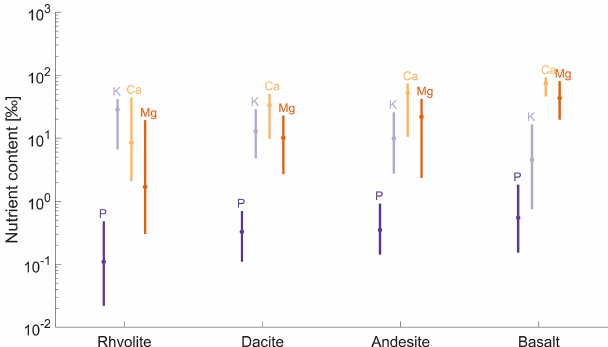
Figure 4. Statistical data of major element concentration in rocks with median values (filled circles) and range (5th and 95th per- centiles; whiskers). Values from EarthChem web portal (http:// www.earthchem.org, last access: 14 July 2017). The numbers of chemical analyses used to calculate the descriptive statistics were 2985 chemical analyses for rhyolite, 3008 chemical analyses for dacite, 11099 chemical analyses for andesite, and 23816 chemical analyses for